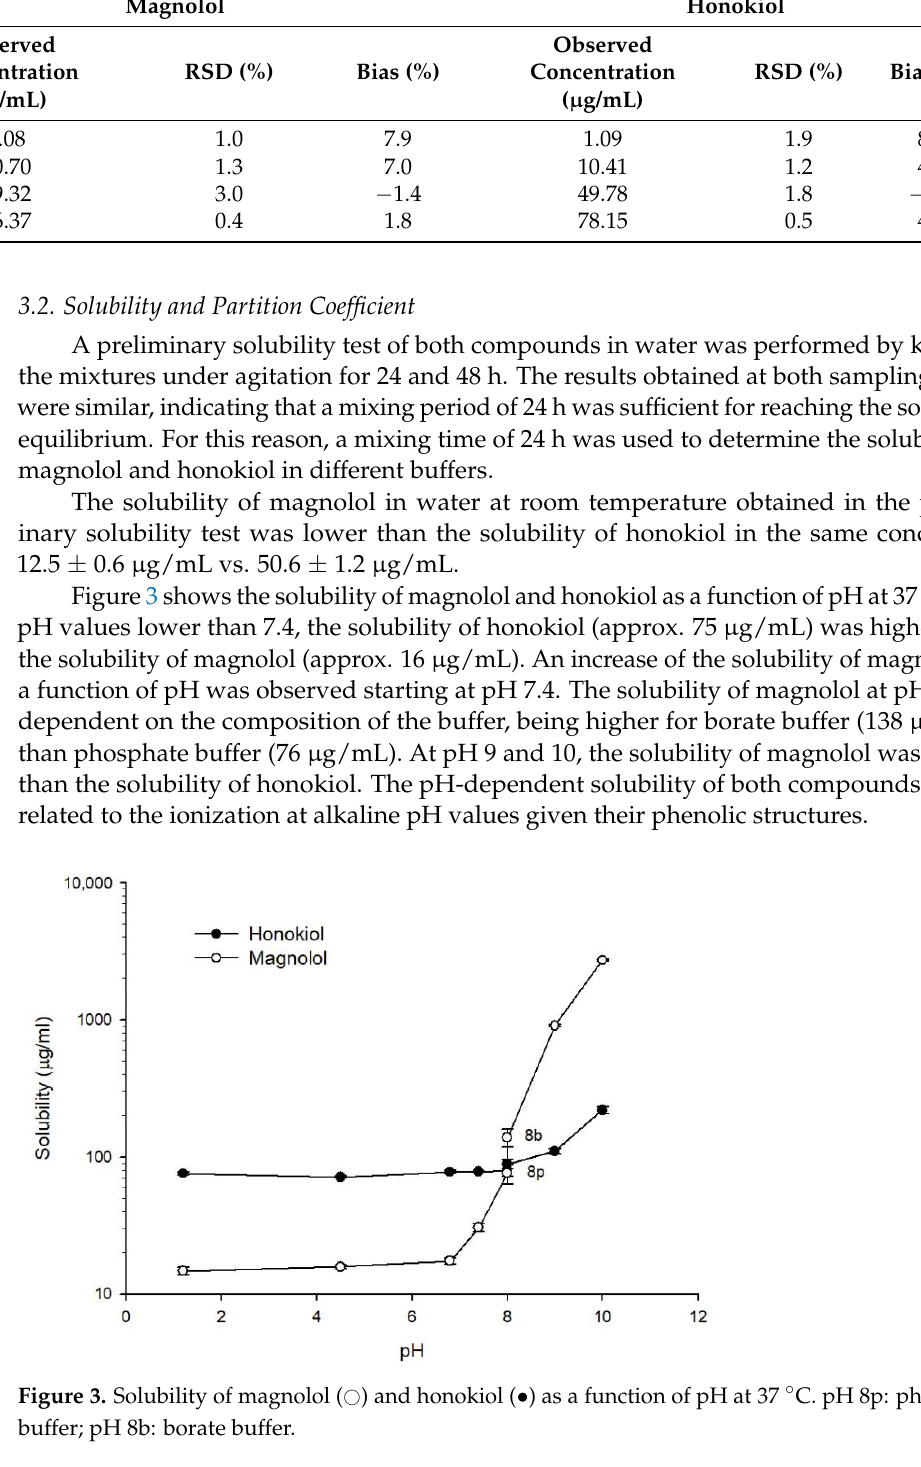
) and honokiol ( • ) as a function of pH at 37 ◦ C. pH 8p: phosphate (cid:35)